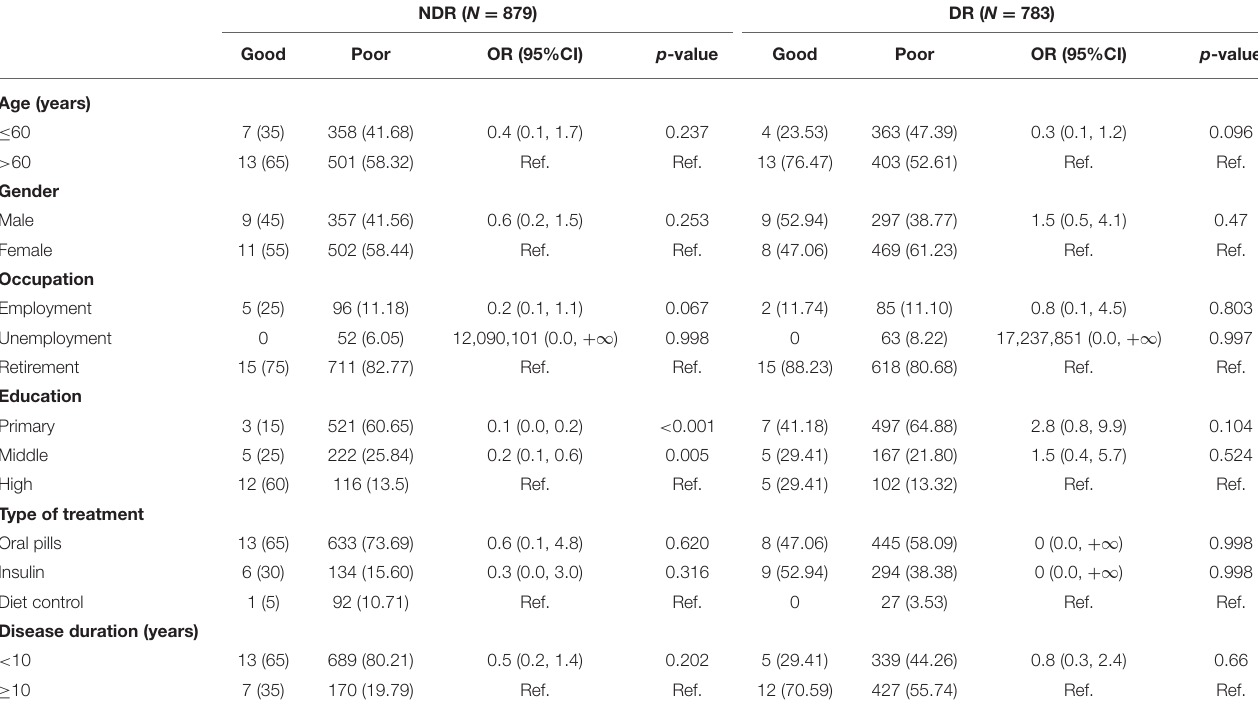
TABLE 2 | Multivariate logistic regression of good knowledge in NDR and DR.